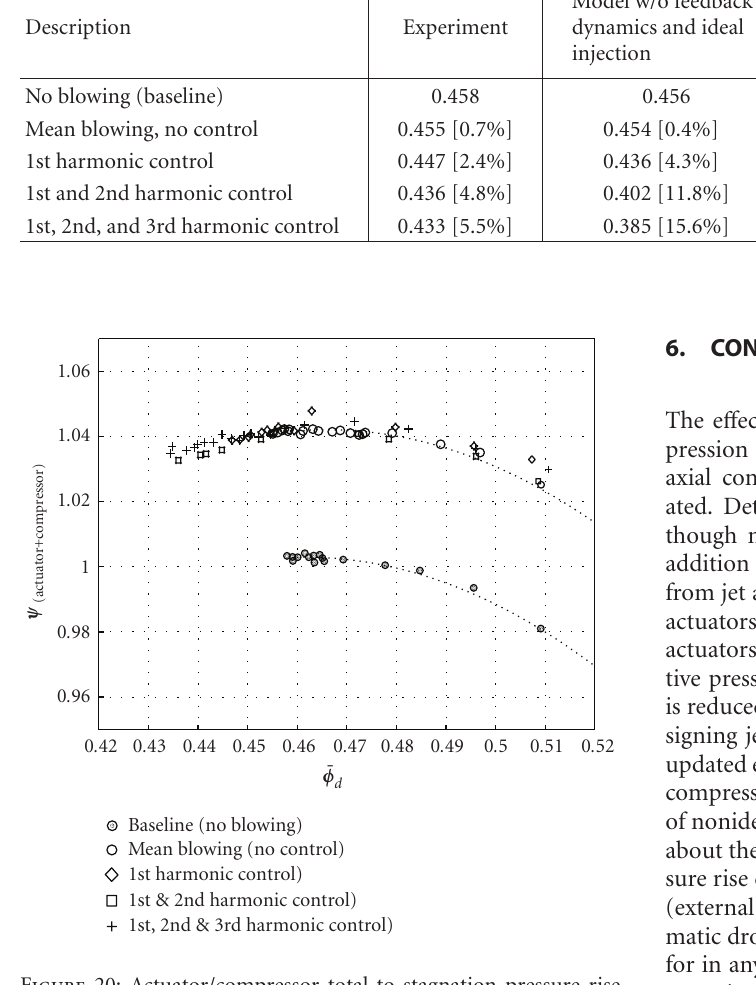
Figure 20: Actuator/compressor total-to-stagnation pressure rise characteristics (speedlines) with and without optimized constant feedback